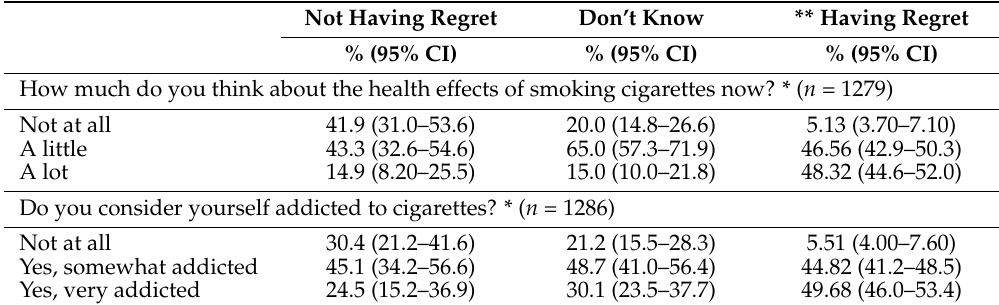
Table 3. Experiential thinking in decision to smoke and addiction perceptions by regret status. Not Having